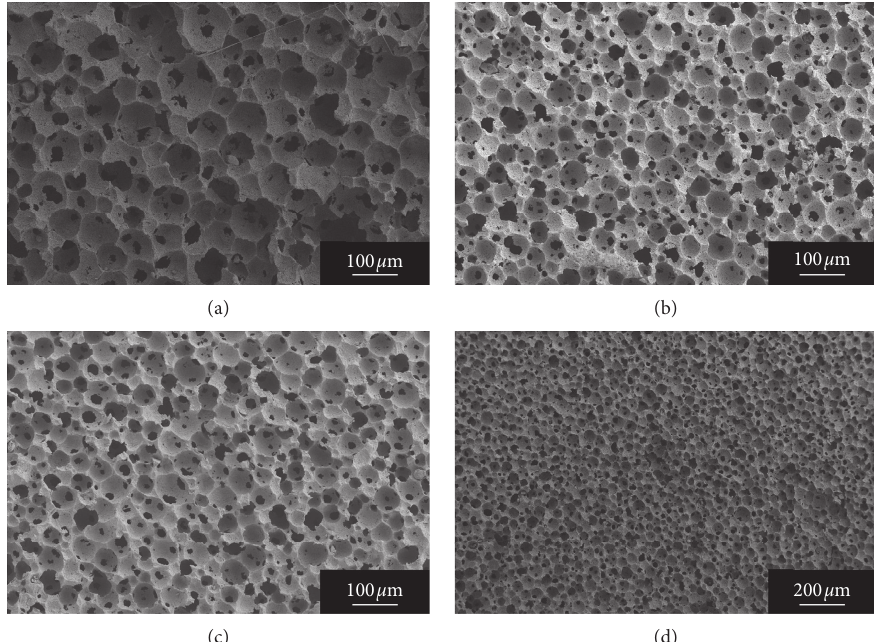
Figure 6: SEM images of cell wall of steel slag foams fabricated with 40 wt.% solid loading sintered at (a) 1150, (b) 1200 ° C, and at (c) (d) 1250 ° C.